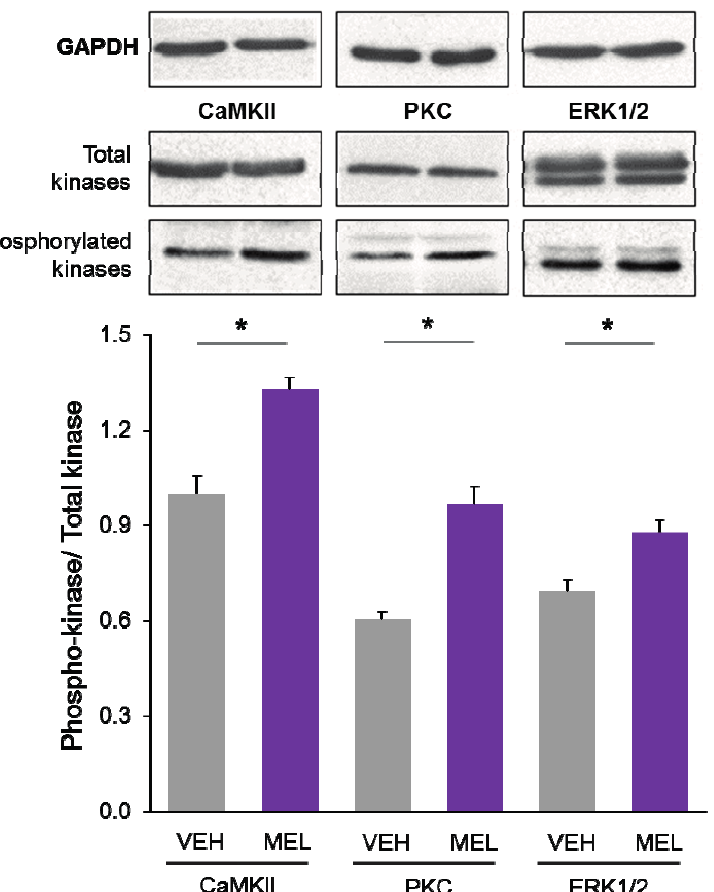
Figure 4. Relative content of phosphorylated Ca 2+ /CaM Kinase II, Protein Kinase C and Extracellular Signal-Regulated Kinase 1/2 in hippocampal slices incubated with Melatonin. Hippocampal slices were incubated for 3 h with either the vehicle (VEH) or 100 nM melatonin (MEL). CaMKII and Thr286-phospho-CaMKII (P-CaMKII), PKC and phospho-PKC (P-PKC) as well as ERK1/2 and phospho-ERK1/2 (P-ERK1/2)